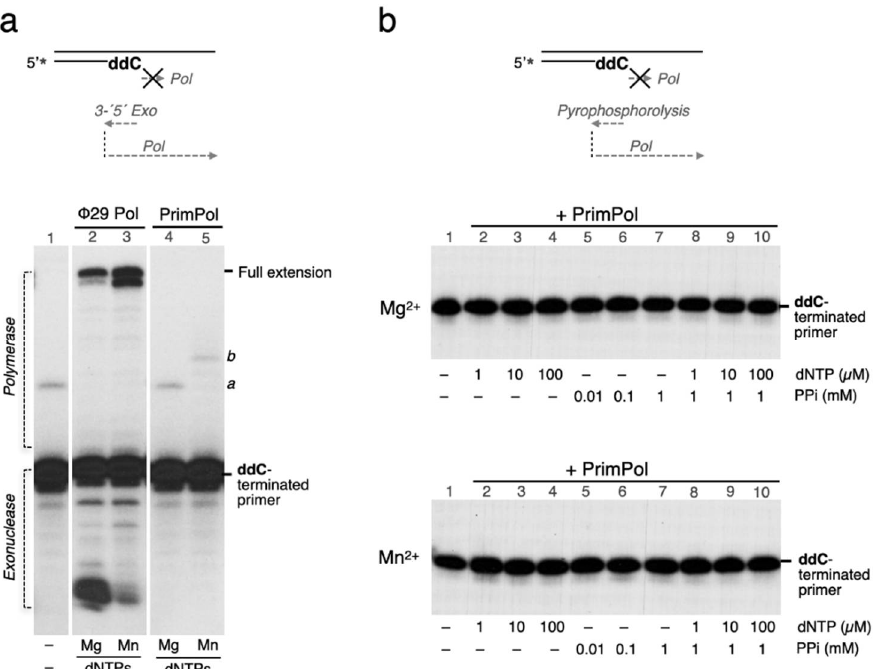
Figure 2. PrimPol cannot remove a 3′-terminal ddCMP. ( a ) Phi29-encoded DNA polymerase (50 nM) was used as a positive control to degrade (via 3′–5′ proofreading) a 2′,3′-dideoxynucleotide (ddC) present at the primer terminus , generating an unblocked primer terminus that can be fully extended in the presence of dNTPs (100 µM) and Mg 2+ (5 mM) or Mn 2+ (1mM) as metal cofactor (lanes 2 and 3). Conversely, PrimPol (50 nM) is not able to remove a 3′-terminal ddCMP with any of the two activating metals, thus impeding elongation of the ddC-terminated primer. a , labelled artefact, present in the original DNA (lane 1); b , dNTPs + Mn 2+ -driven extension of the artefact band (lane 5). ( b ) PrimPol (200 nM) is not able to remove a 2′,3′-dideoxynucleotide (ddC) present at the primer terminus by pyrophosphorolysis, neither with Mg 2+ (upper panel) or Mn 2+ (lower panel). Increasing concentration of PPi (0.01, 0.1, 1 mM), alone or in combination with dNTPs (1, 10, 100 µM), did not produce any ddC removal from the primer terminus or the subsequent elongation